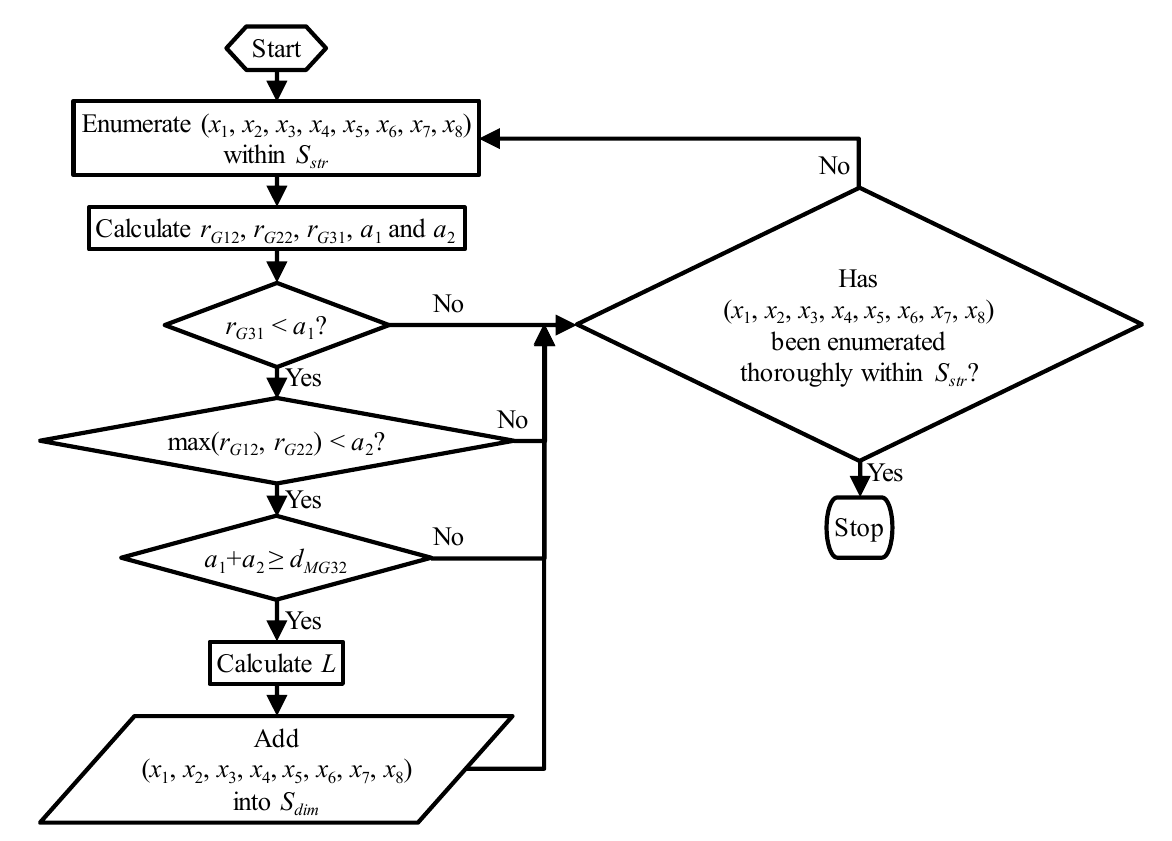
Figure 12. Scheme of the enumeration for the dimensions.